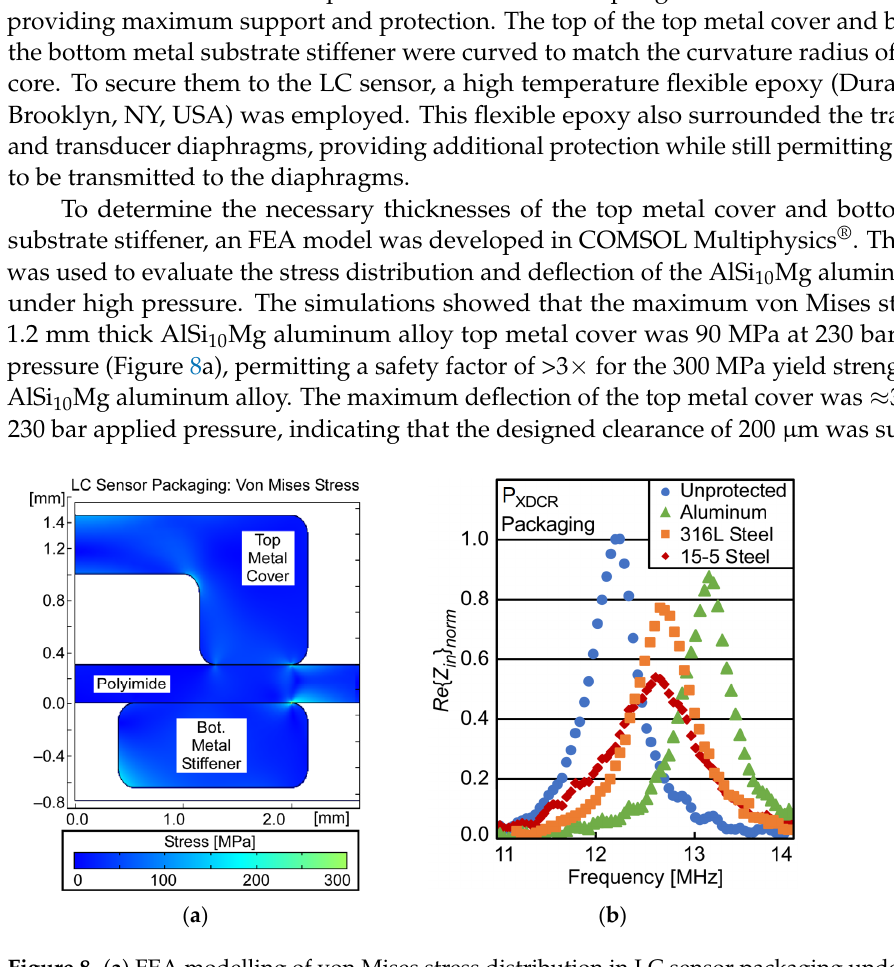
Figure 8. ( a ) FEA modelling of von Mises stress distribution in LC sensor packaging under applied pressure of 230 bar. ( b ) Experimental Re { Z in } datasets for LC sensors in unpackaged and packaged configurations. Assumed material properties for FEA given in Table 4.